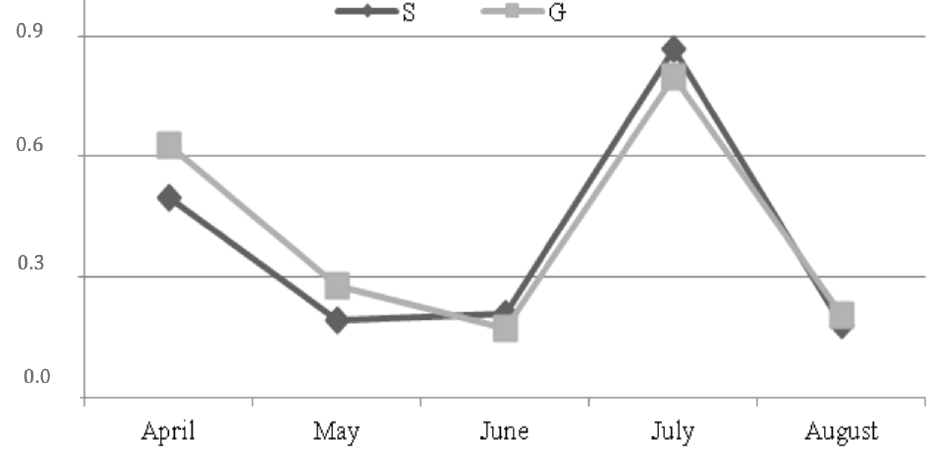
Figure 3. Expression of miRNA 103 (AU: Arbitrary unit) along the trial (*SEM = 0.121). * standard error of mean.